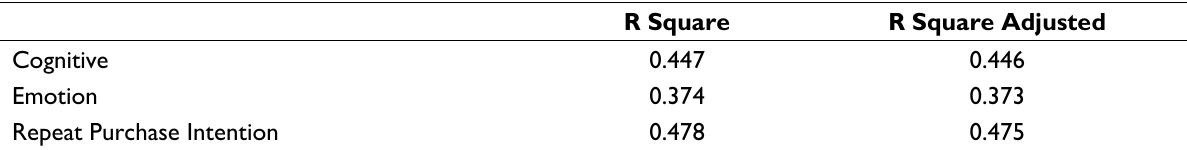
Table 5. The R Square